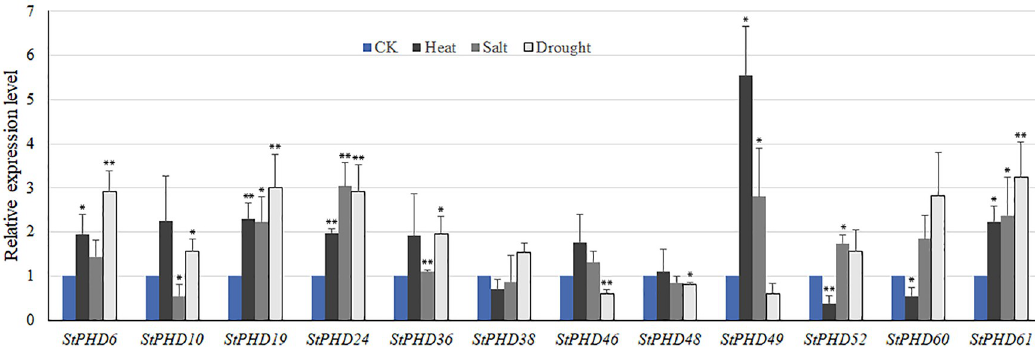
Fig 8. Relative expression level of 12 StPHD genes in response to heat, salt and drought stress at 6 h. The error bars indicated standard deviation. Asterisks indicated that the expression level was significantly different from the value of the control ( � P < 0.05, �� P <